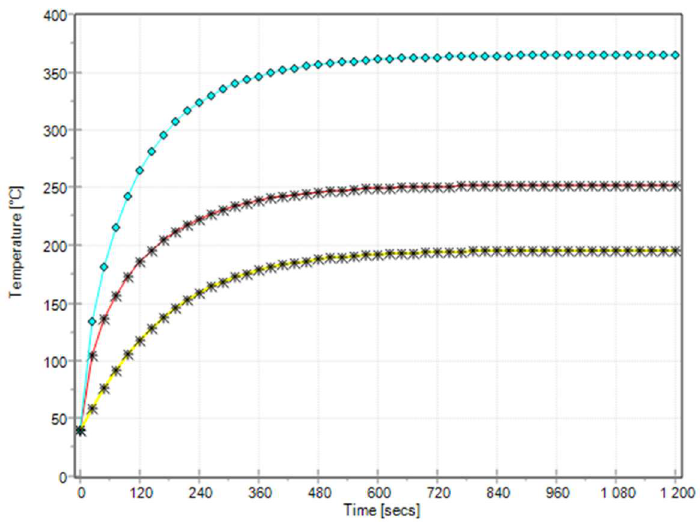
Figure 9. The temperatures of individual motor parts as a function of time: blue curve—rotor heating; red curve—stator heating; yellow—windage heating.